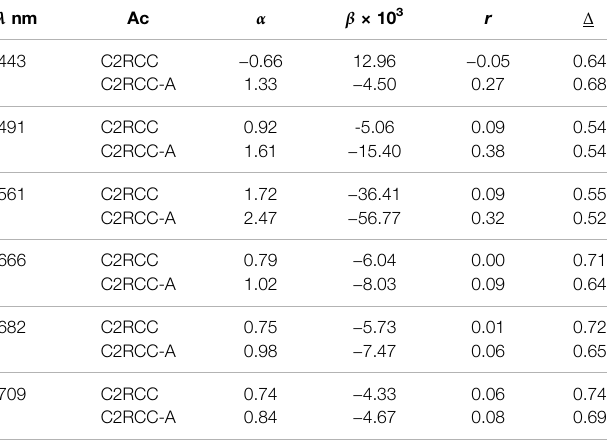
TABLE 3 | Radiometric validation of atmospheric corrections applied to